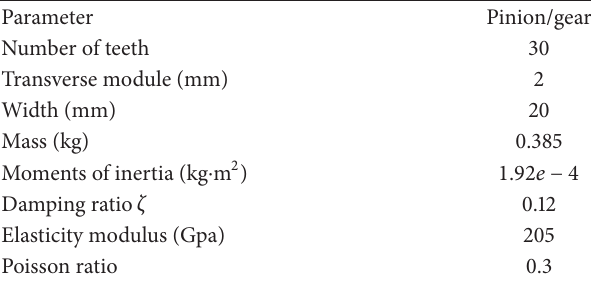
Table 1: Common design parameters of the spur gear pairs.